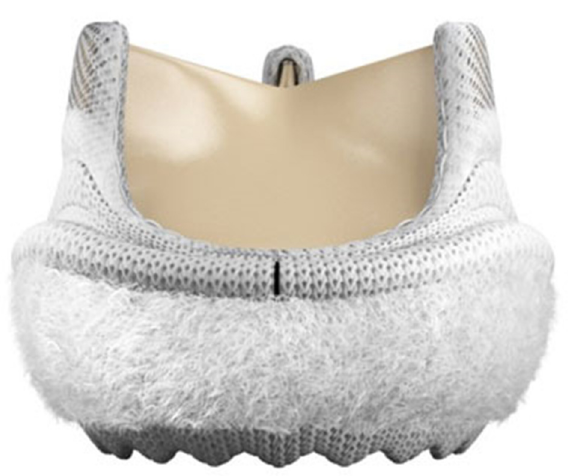
Figure 1. The rapid-deployment Intuity™ aortic valve system (Edwards Lifesciences, Irvine, CA, USA).